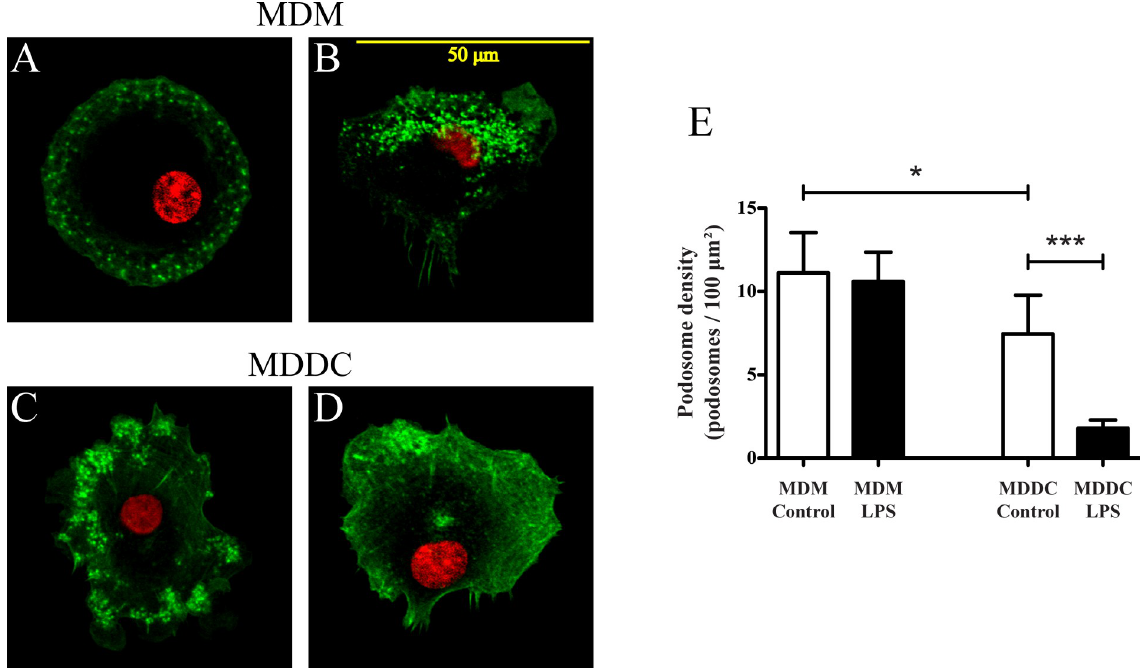
Fig 4. Changes in the arrangement of podosomes in the contact surface of adherent cells upon LPS treatment. The actin cytoskeleton of adherent cells was stained with phalloidin-Alexa488 (shown in green), nuclei were stained with Draq5 DNA dye (shown in red). Both untreated (A) and LPS treated (B) MDMs form podosomes during adhesion, whereas only untreated, immature MDDCs (C) contain these structures, LPS treated mature MDDCs (D) lose their ability for podosome formation. The number of podosomes and cell area were measured on 40–60 cells/sample with ImageJ software (E), data are shown as podosome density (number of podosomes per 100 μ m 2 of cell covered area). One-way ANOVA with Tukey’s post-test was used to determine significant differences compared to control, � = p < 0.05, ��� = p < 0.001. Representative microscopy pictures (A-D) are shown out of 5 (MDMs) or 7 (MDDCs) donors’ results and podosome density data (E) are shown as mean ± SD of the above data.